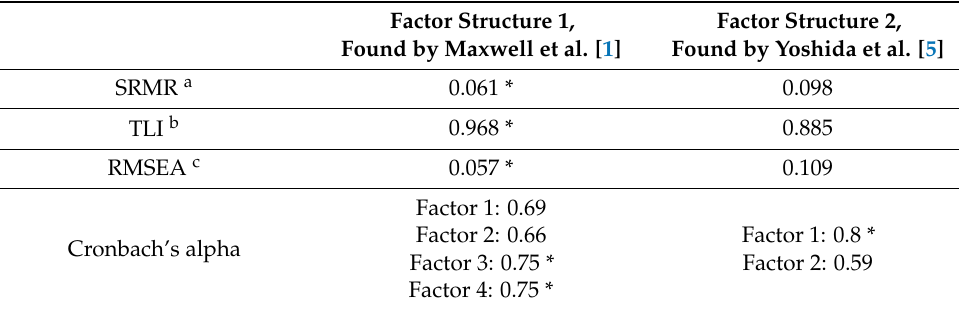
Table 3. Fit indices and Cronbach’s alpha values for the two assessed factor structures. Factor Structure 1, Factor Structure 2, Found by Maxwell et al. [1] Found by Yoshida et al.